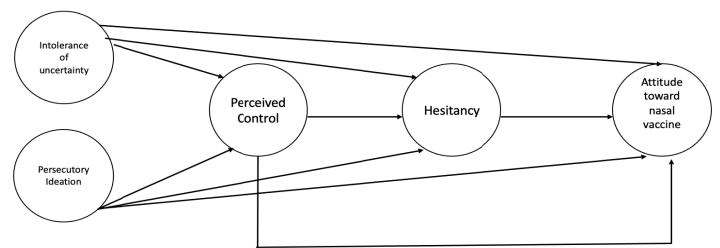
Figure 1. Conceptual model. These variables are latent and measured through the parcels method. The relationships among these variables will be tested while controlling for the following socio- demographic variables: gender, age, educational level, health professional worker, and organic dis- ease.